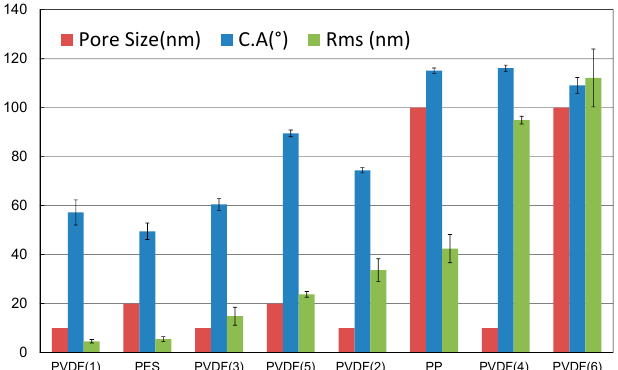
Figure 11. Substrate surface characteristics: pore size, contact angle (CA), and surface roughness (RMS value). Graphene Transfer onto Polymeric Substrates: